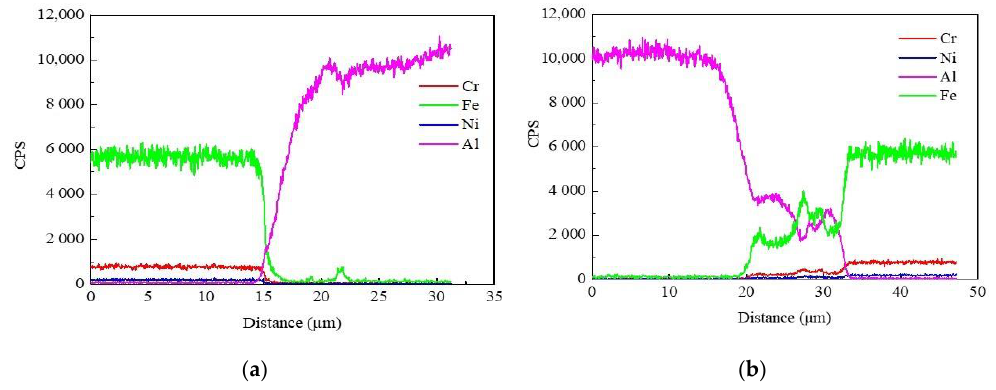
Figure 12. Element distributions of the 3003–321 interface at different areas. ( a ) EDS line scan of line 1; ( b ) EDS line scan of line 2. Table 3. Point EDS compositional result at the interface of the interlayer and target sheet (at. %).